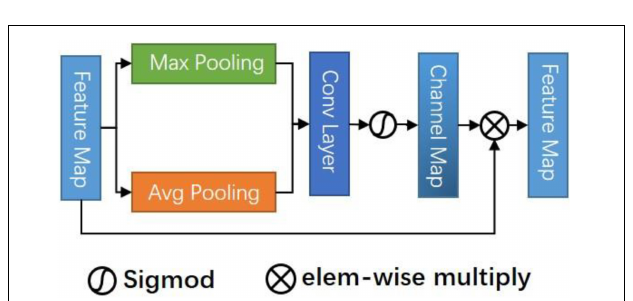
FIGURE 2 | Cross space attention module (CSAM).